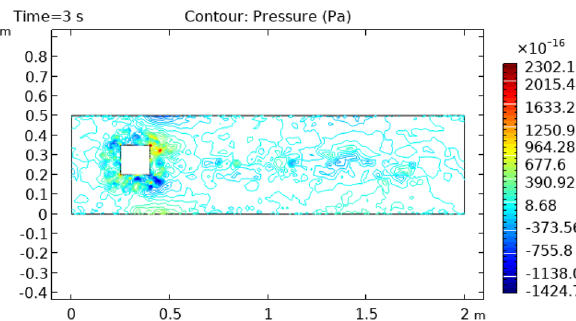
Figure 7. Pressure distribution in squared cylindrical flow at t = 3 s.